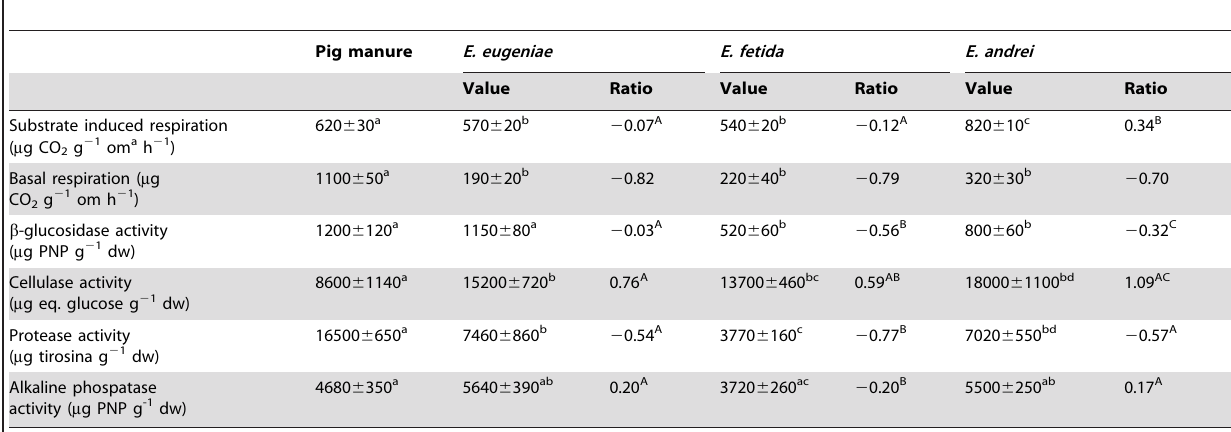
Table 1. Microbiological characteristics of the fresh pig manure and vermicomposts from three earthworm species ( Eudrilus eugeniae . Eisenia fetida and Eisenia andrei